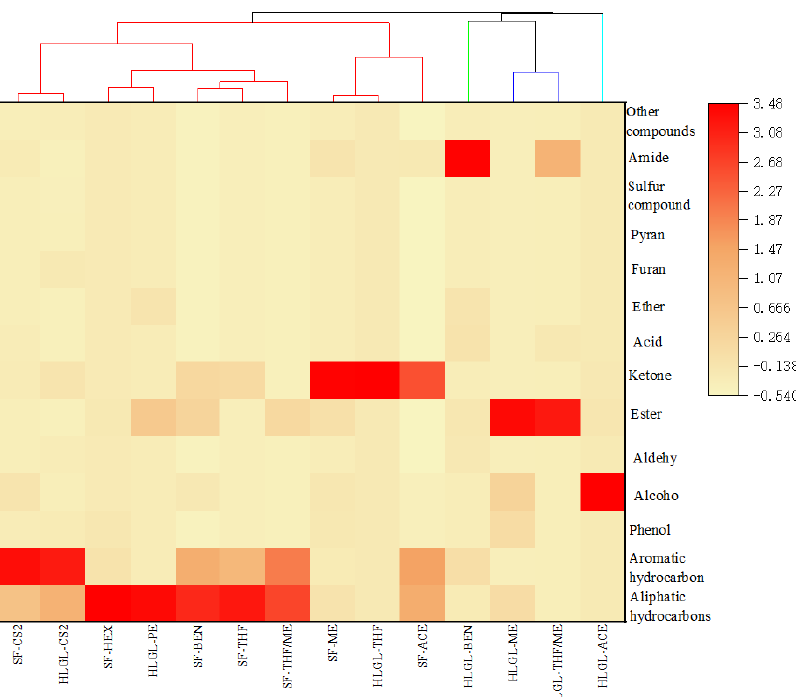
Figure 7. Heat map of clustering of 14 groups of extract family composition based on GC/MS data.